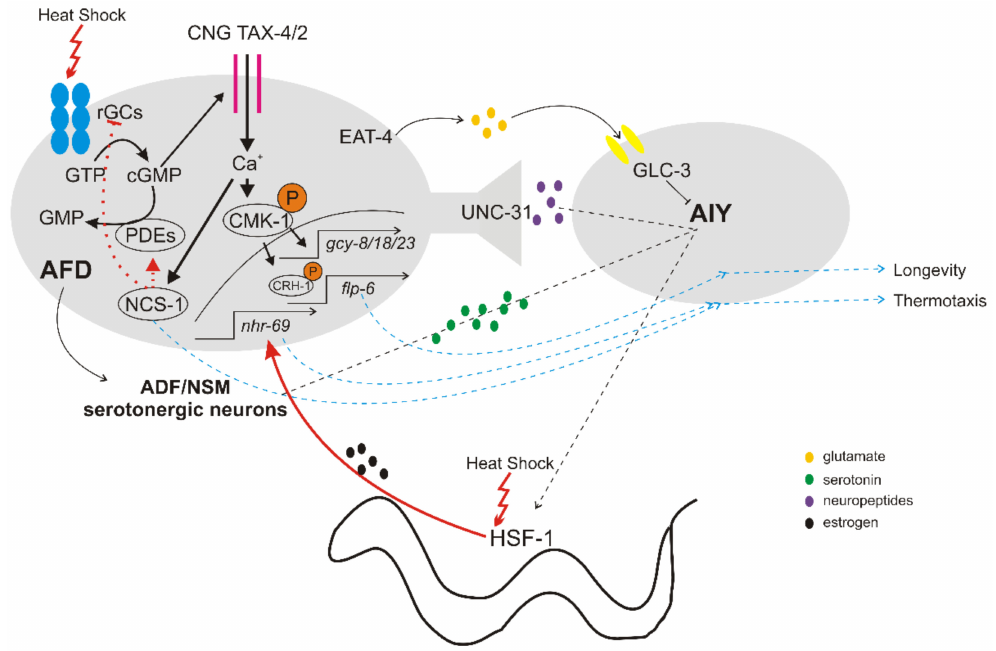
Figure 1. Schematic representation of AFD/AIY thermosensory circuit signaling. Temperature rising is received in AFD sensory neurons by rGCs that upregulate cGMP concentration. This leads to the opening of the CNG TAX-4/TAX-2 channels and the release of a calcium influx, resulting in depolarization of AFD membrane potential. The calcium influx maintains cGMP concentration levels through NCS-1 and further upregulates rGCs via CMK-1 phosphorylation. Phosphorylated CMK-1 enters the nucleus and among regulation of rGCs expression levels, also participates in CRH-1 phosphorylation and subsequent FLP-6 activation that is responsible for normal longevity under elevated temperatures. AFD activation leads to both excitatory and inhibitory signal transmission on AIY interneuron possibly by UNC-31-mediated peptides release and by glutamate release, accordingly. This activation can also release serotonin from serotonergic neurons and upregulate HSF-1 through AIY in the intestine. These signals are necessary for AIY to promote thermal behaviors (thermotaxis) and activate HSF-1-related organismal thermal responses in somatic tissues. In succession, HSF-1 can also signal to AFD in part through estrogen signaling to ensure normal